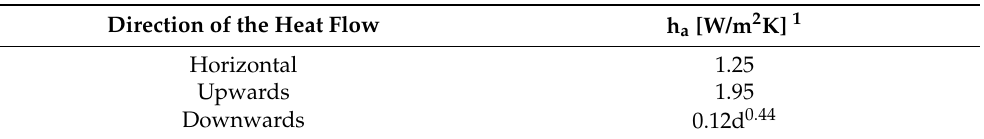
Table 2. Values for the convective heat transfer coefficient (h a ) according to the direction of the heat flow for temperature difference lower than 5 K